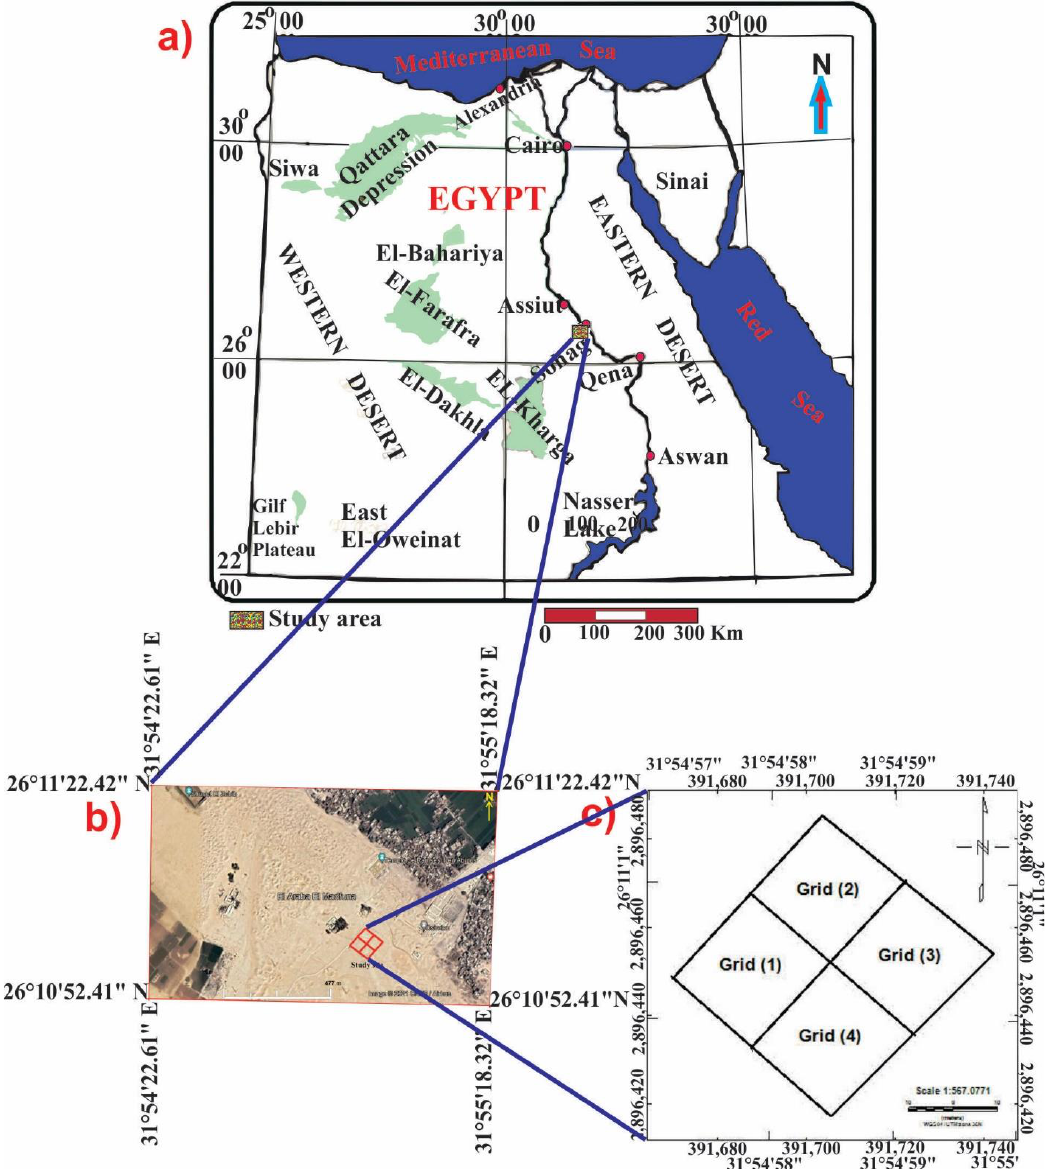
Figure 1. ( a ) Map of Egypt indicating the location of the study region in Sohag Governorate; ( b ) Google Earth photograph of the Abydos site indicating the study area; and ( c ) Map displaying the details of the surveyed grids for both ground magnetic survey and GPR application on the investi- gated site.